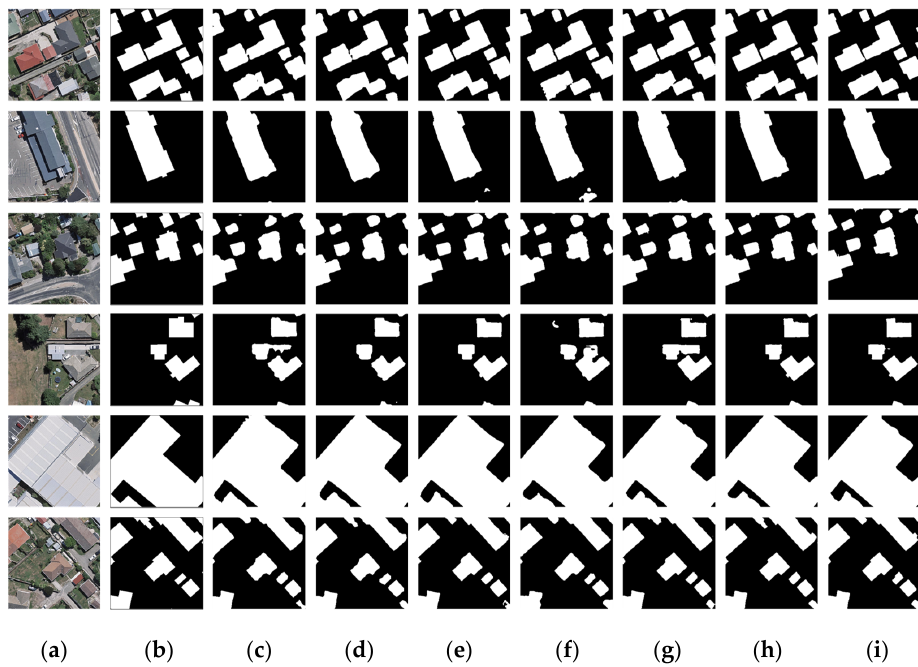
Figure 12. Results obtained by different semantic segmentation methods on the Wuhan University building change detection dataset, ( a ) 2016 image, ( b ) 2016 ground truth, ( c ) PSPNet, ( d ) DeepLabV3, ( e ) OCRNet, ( f ) Segformer, ( g ) SwinTransformer, ( h ) UNet(ResNet50), and ( i ) UNet(EfficientNet-b1).